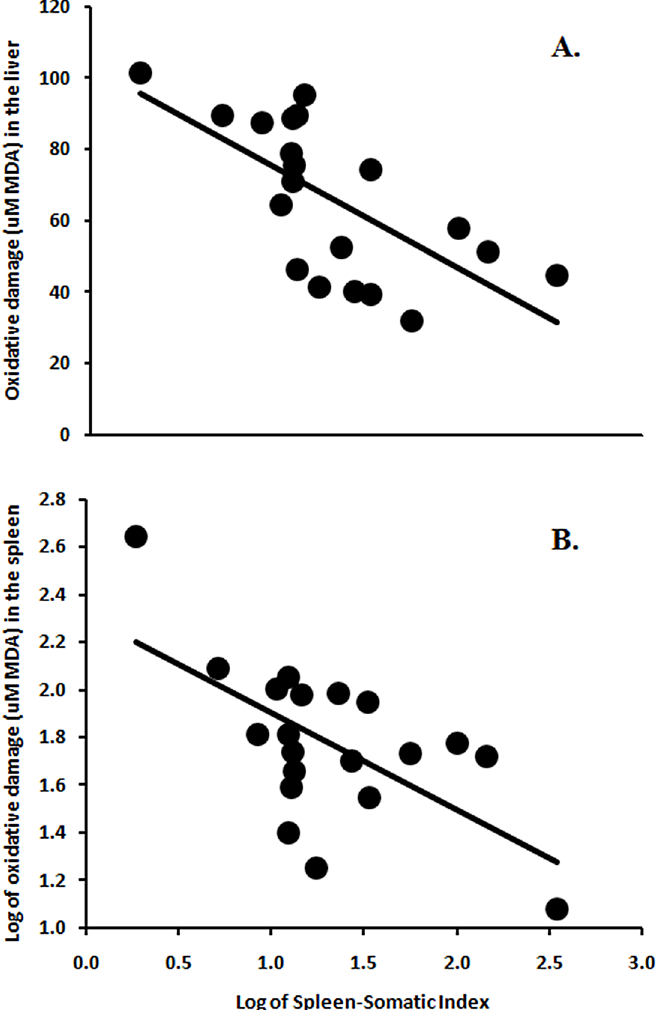
Fig 3. Spleen size and oxidative damage in liver and spleen. Regardless of treatment, chameleons with relatively larger spleens had lower levels of oxidative damage (as assessed by production of MDA) in both liver (A) and spleen (B) tissues.